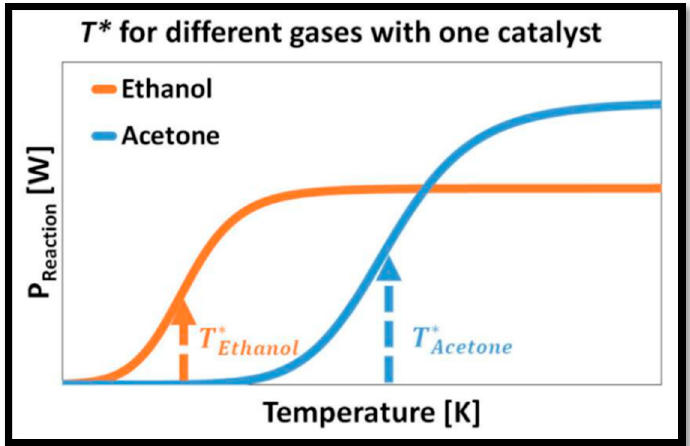
Figure 1. Comparison between Ethanol and Acetone gases. For the same catalyst, different T* are obtained.